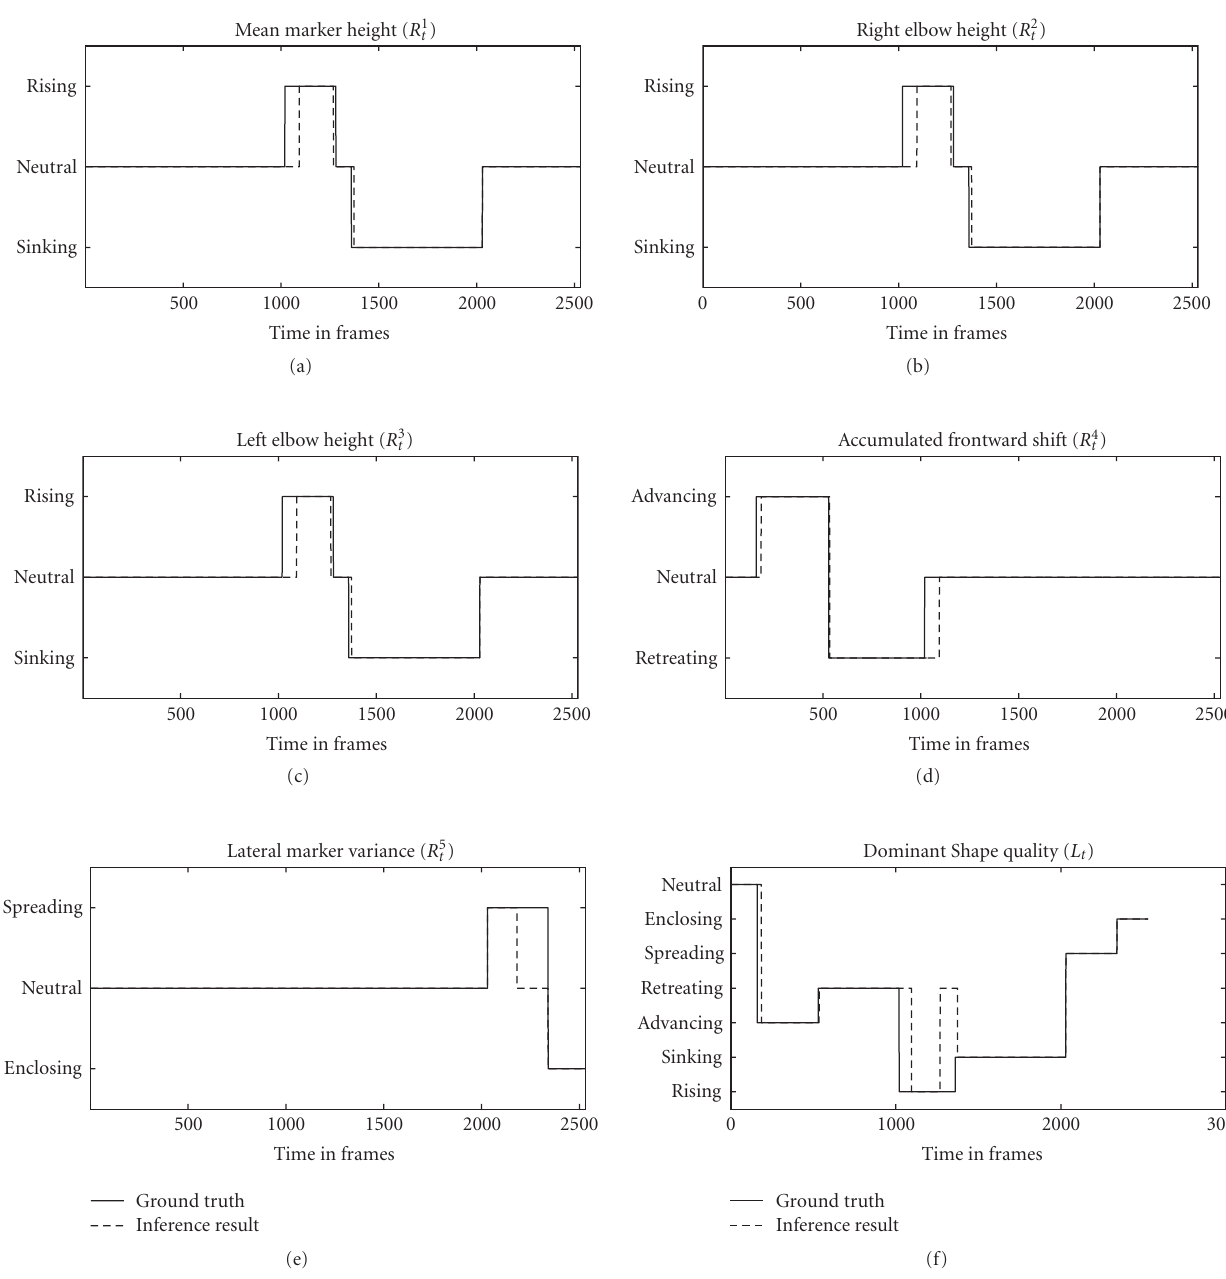
Figure 10: Segmentation performance on “Menu 1” (dancer 1) movement data showing the fusion of di ff erent features to infer the dominant Shape